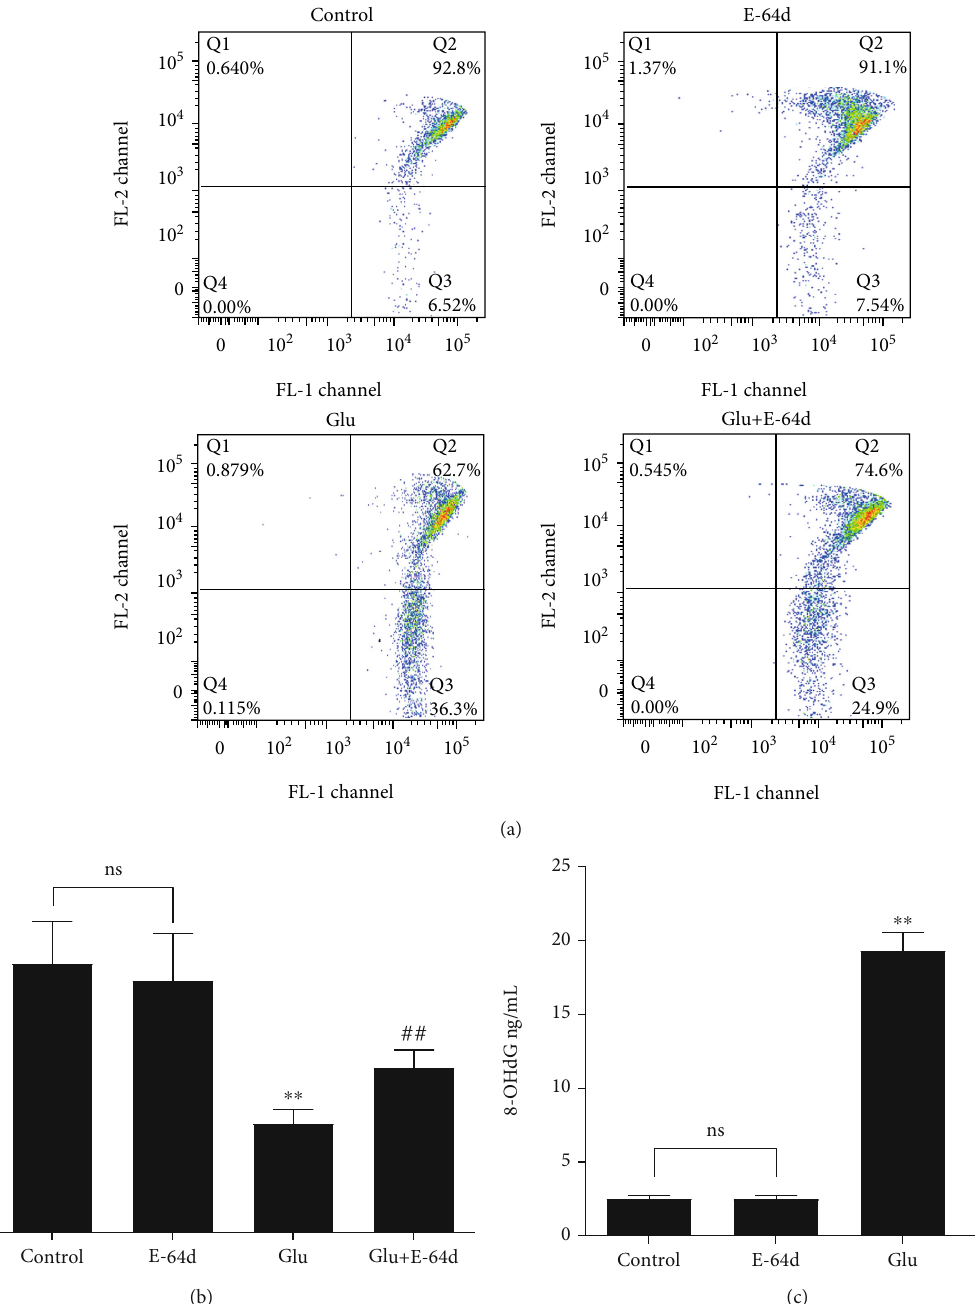
Figure 4: E ff ect of E-64d on glutamate-induced changes in mitochondrial membrane potential in terms of JC-1 activity and oxidative stress, as detected via ELISA. (a) Measurement of mitochondrial membrane potential via fl ow cytometry. (b) Quantitative analysis of mitochondrial membrane potential in HT22 cells. (c) Quantitative analyses of the average levels of 8-OHdG in cells. Three independent experiments were performed, and the data are expressed as the mean ± SD . ∗∗ P < 0 : 01 vs. the Control group. ## P < 0 : 01 vs. the Glutamate group. n.s.: not signi fi